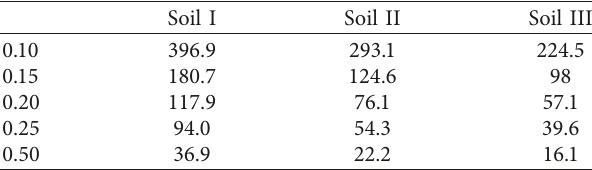
Table 4: Coefficient a in the Chilean code